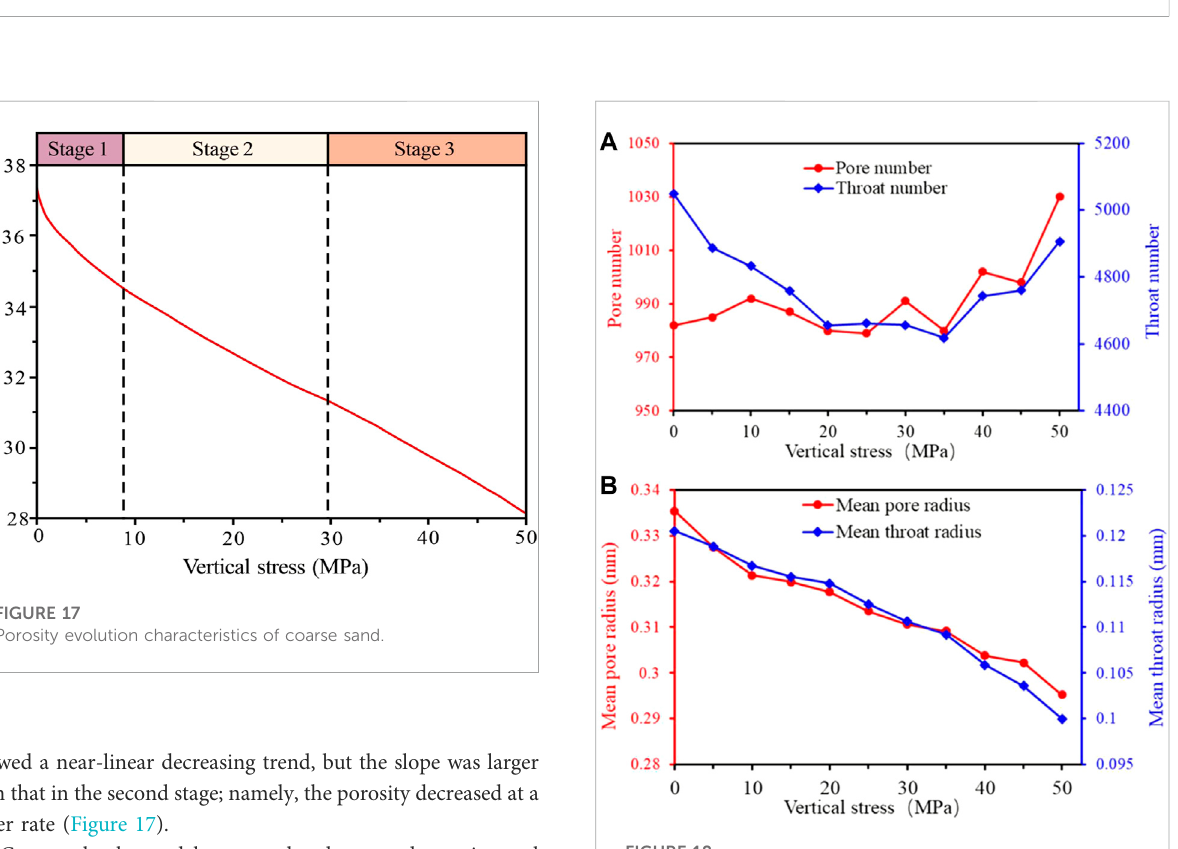
FIGURE 18 Evolution of pore structure characteristics of coarse sand: (A) number of pores and throats and (B) mean radii of the pore and